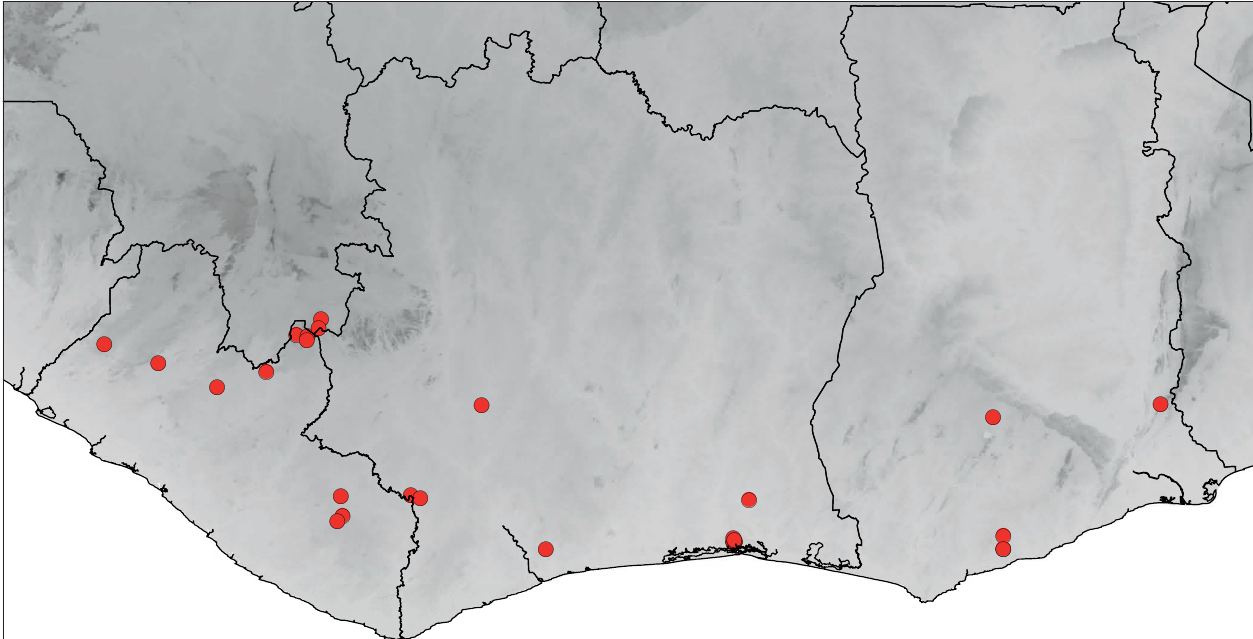
Figure 10 – Distribution of Rhigiocaya leonensis . Map created with ArcMap 10.7.1 (ArcGIS Desktop v.10.7.1; Esri 2019). © Esri and its licensors, all rights reserved.